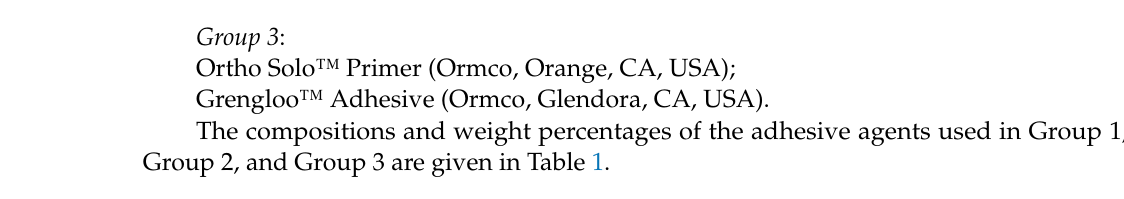
Table 1. Compositions and weight percentages of adhesive agents used in the